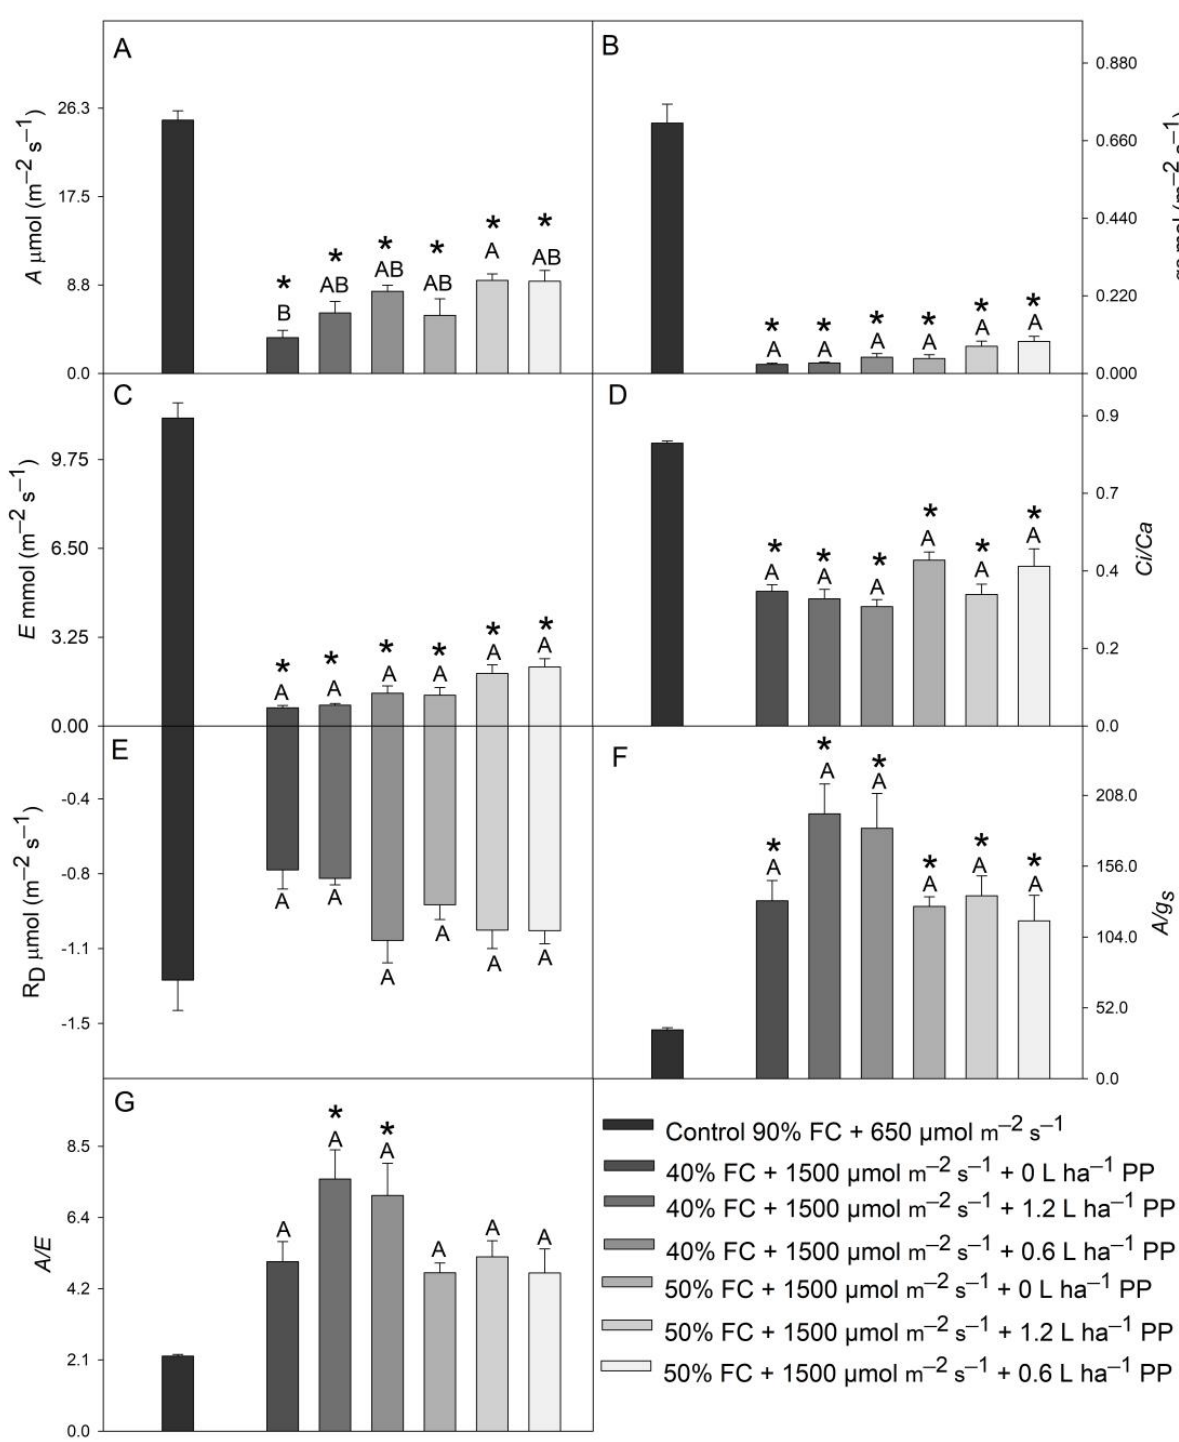
Figure 3. Photosynthetic rate ( A ; ( A )), stomatal conductance ( g s ; ( B )), transpiration ( E ; ( C )), ratio between the internal and external concentration of CO 2 (C i /C a , ( D )), dark respiration (R D € ; ( E )), in- stantaneous water use efficiency ( A / gs ; ( F )) and intrinsic water use efficiency ( A / E ; ( G )) of soybean plants treated with doses of potassium phosphite (PP), and exposed to water deficit + high irradiance for 12 days. Bars represent mean ± SEM ( n = 5). Means followed by asterisk (*) differ from control by Dunnett’s test ( p < 0.05). Means followed by the same letter did not differ among stress treatments, as determined by Tukey’s test ( p <